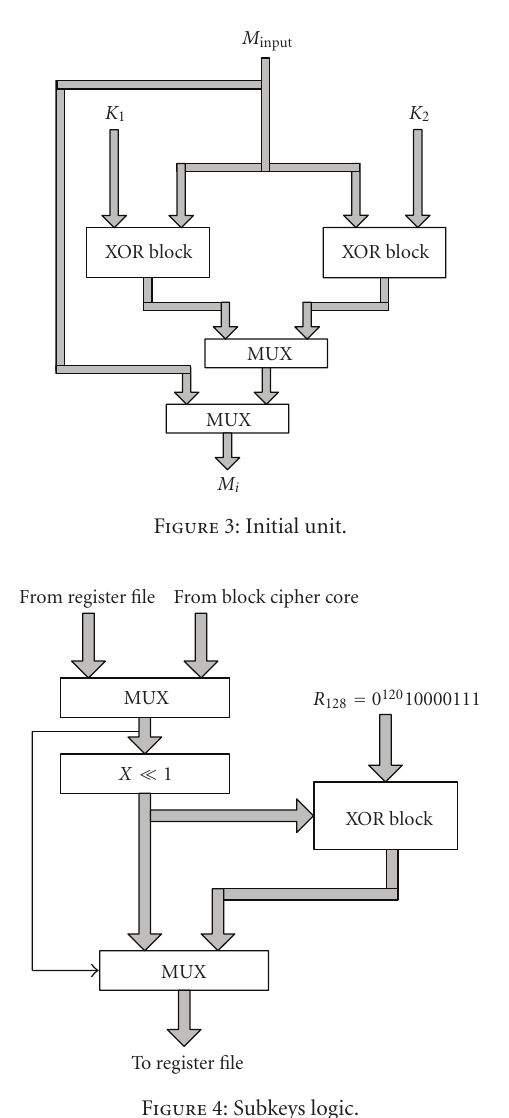
Figure 4: Subkeys